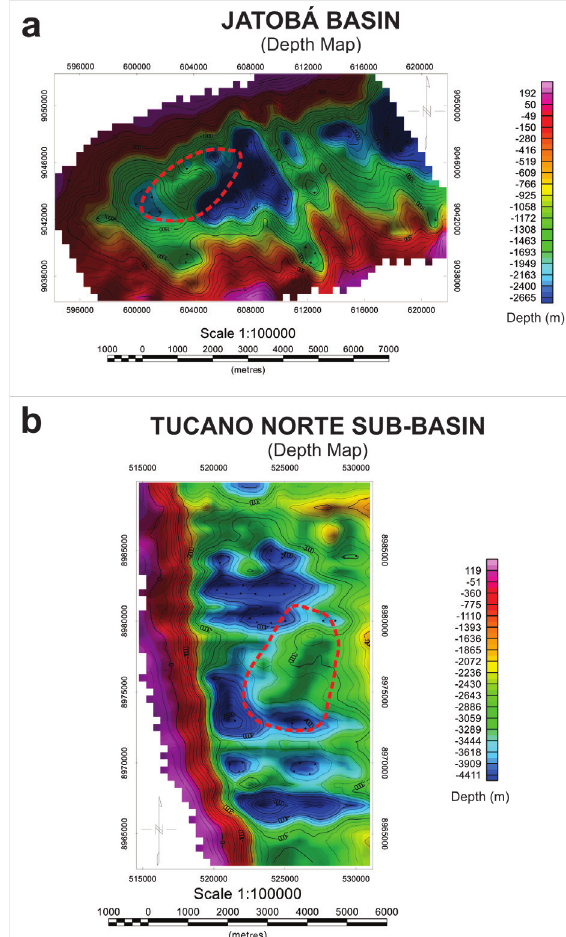
Figure 9. Framework of the crystalline basement in the Jatobá Basin (a) and Tucano Norte Sub-basin (b) calculated with 2D modelling. The dashed areas in red represent horsts of the basement that are under Aptian sedimentary